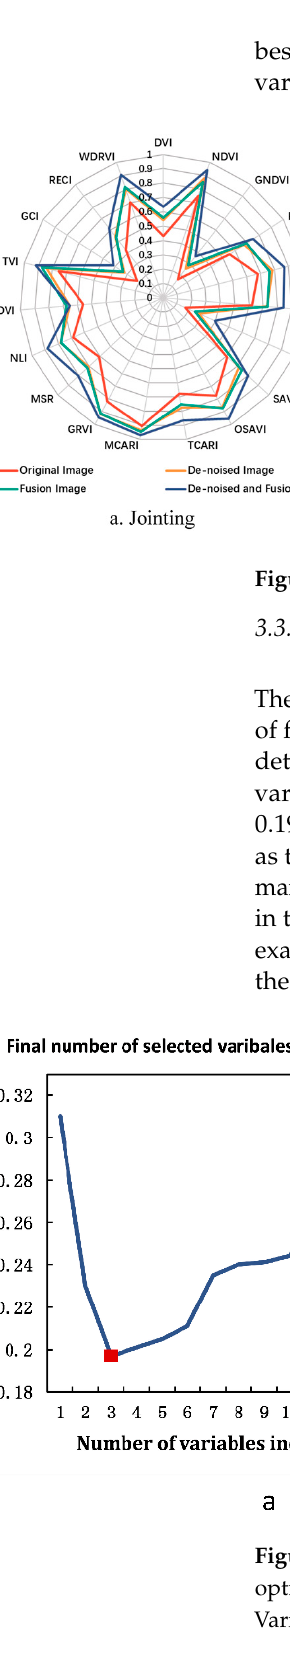
Figure 9. Process of variable extraction by SPA. ( a ) The variation of RMSE. ( b ) The selection of op- timal variables (the value of VIs is the size of the actual value of the vegetation index, and the Vari- able Index is the number of vegetation indices entered into the algorithm).